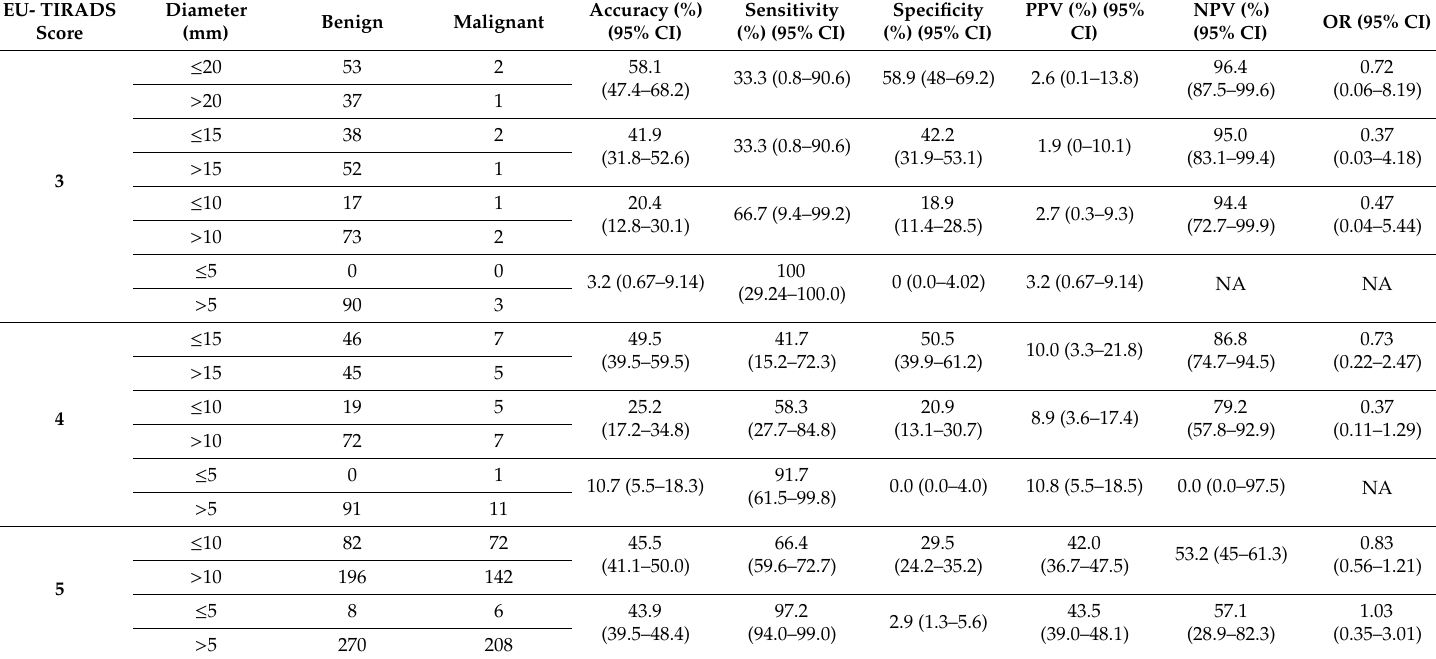
Table 5. Statistical analysis with the classification of thyroid lesions into appropriate EU-TIRADS categories and in relation to their size and malignancy risk. Not applicable (NA) is presented to avoid dividing by